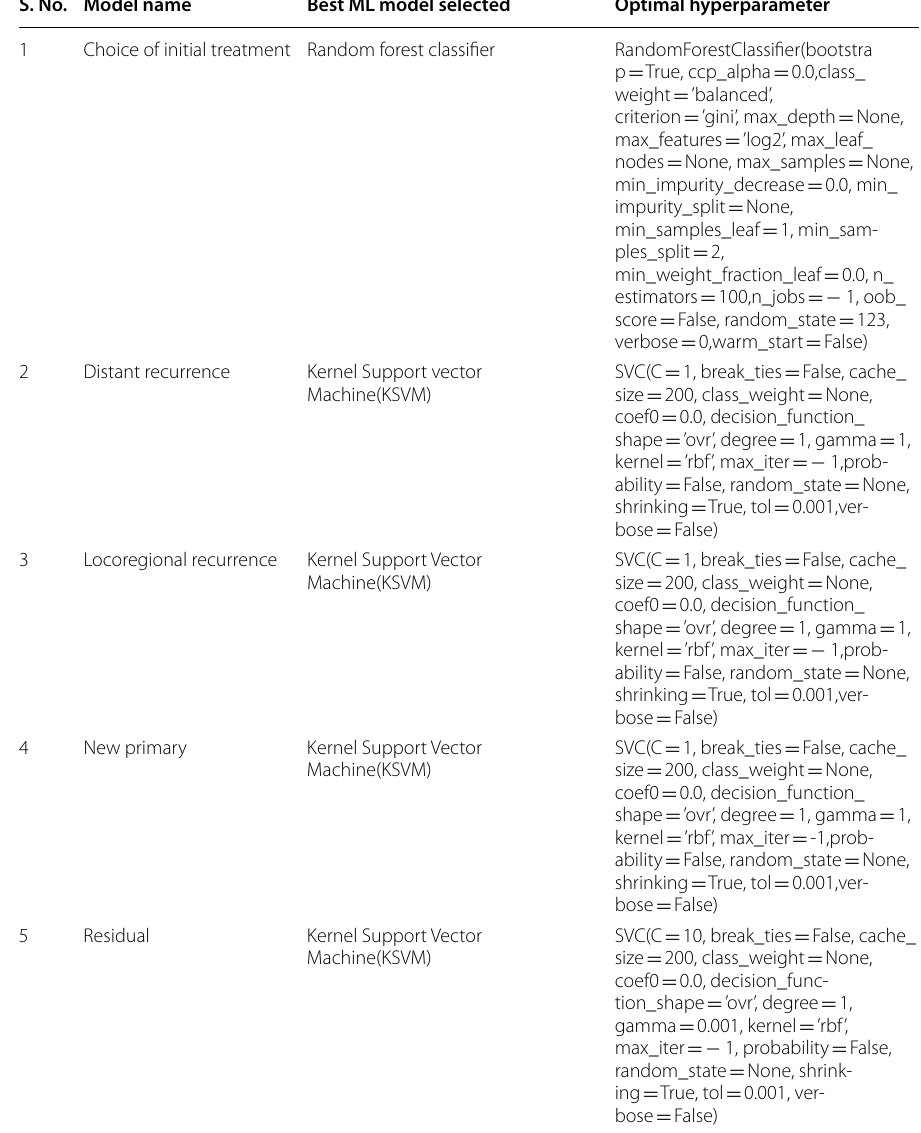
Table 11 Optimal hyperparameters were calculated for each model with all three algorithms (RF, SVM, and